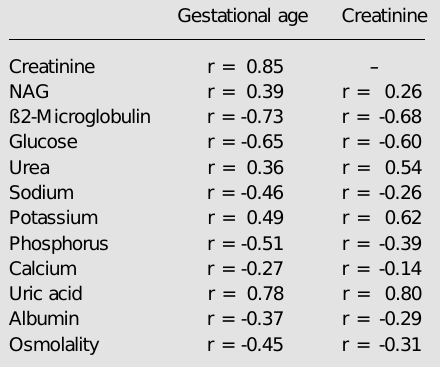
Figure 1. The amniotic fluid pro- file of creatinine, N-acetyl-ß-D- glucosaminidase (NAG), ß2-mi- croglobulin, sodium and uric acid at three time points during ges- tation. A , Creatinine x gesta- tional age. B , NAG x gestational age. C , ß2-Microglobulin x ges- tational age. D , Sodium x gesta- tional age. E , Uric acid x gesta- tional age. The total number of samples measured for each marker are given on the x axis and the values found for each biochemical marker at the three gestational time points are given on the y axis. The number of samples studied is given in pa-